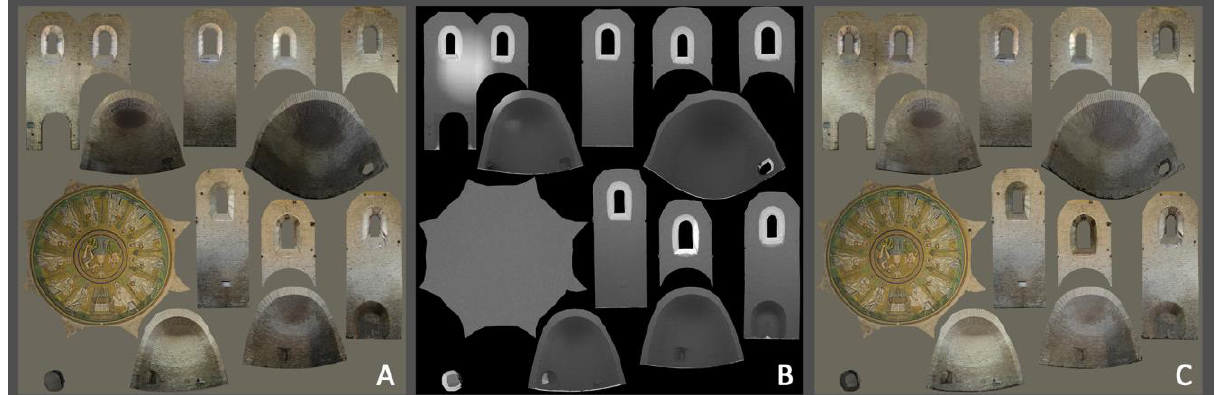
Figure 10. A) Apparent colour texture from SfM application; B) indirect illumination baked on the same (u,v) reference system; C) colour texture after shadow